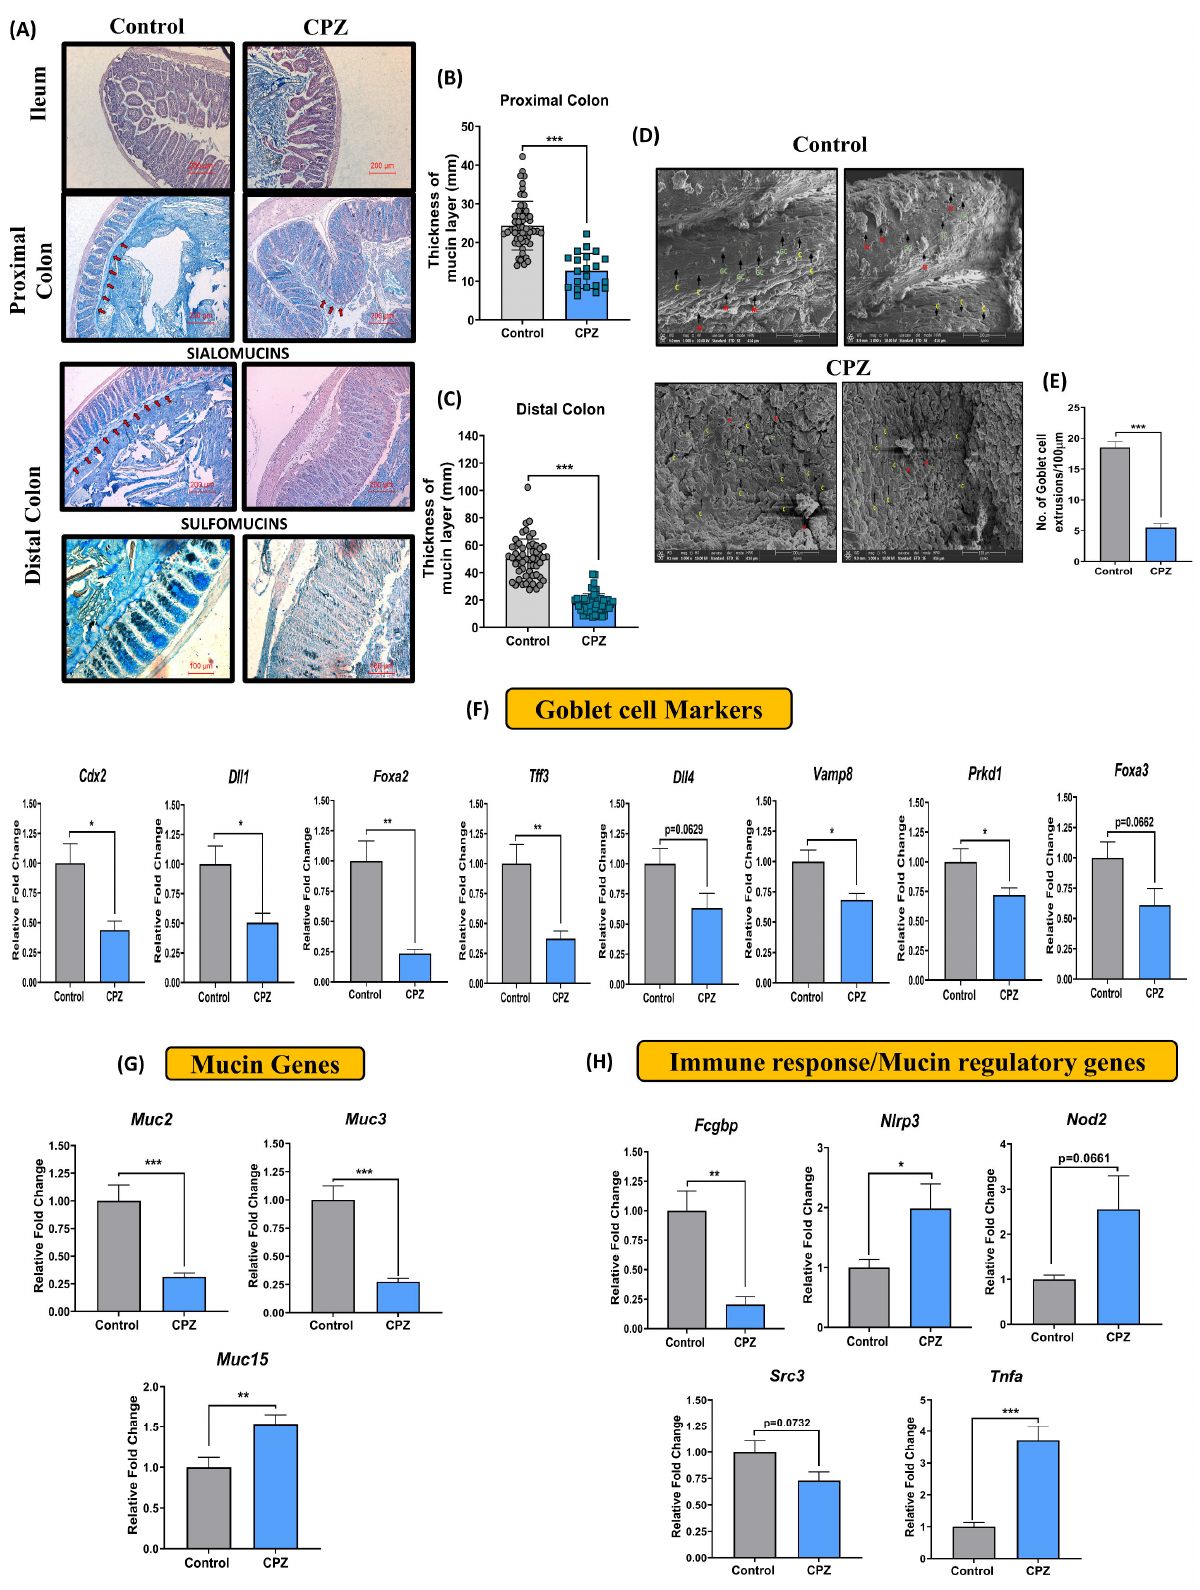
Figure 1. Effect of CPZ rectal administration on colonic mucus production. Histology representative images of ( A ) Hematoxylin and Eosin—Alcian blue staining in ileum, proximal, and distal colon ( n = 3), High iron diamine—Alcian blue staining in distal colon ( n = 3), ( B ) thickness of mucus layer in proximal colon, ( C ) thickness of mucus layer in distal colon. ( D ) representative images for SEM